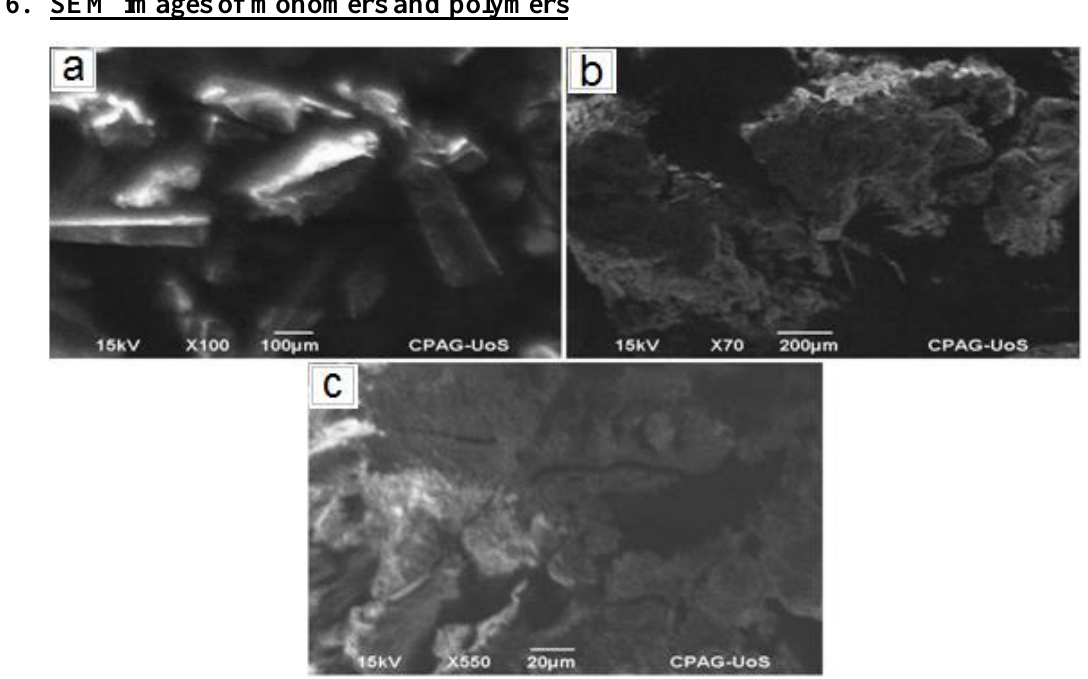
Figure S21: SEM images of monomer m -HOB and its derived polymer P m HOBND, (a) m - HOB, (b) P m HOBND at 200 µm and (c) P m HOBND at 20 µm